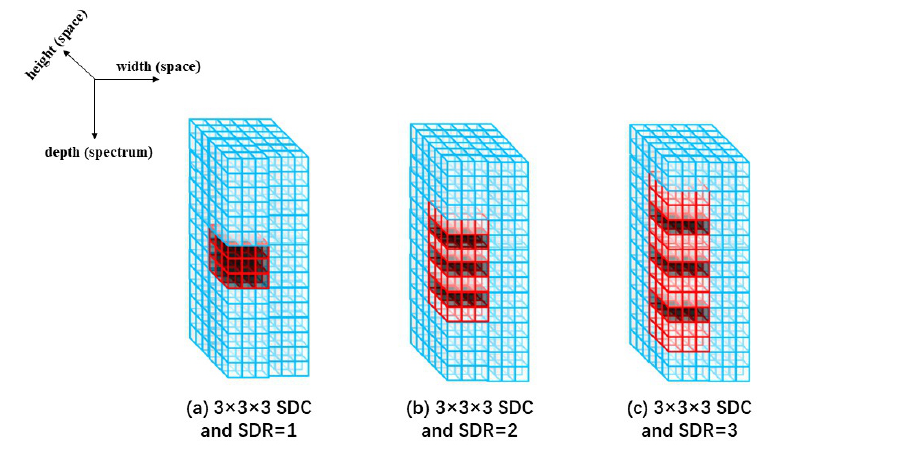
Figure 5. Schematic of spectral dilated